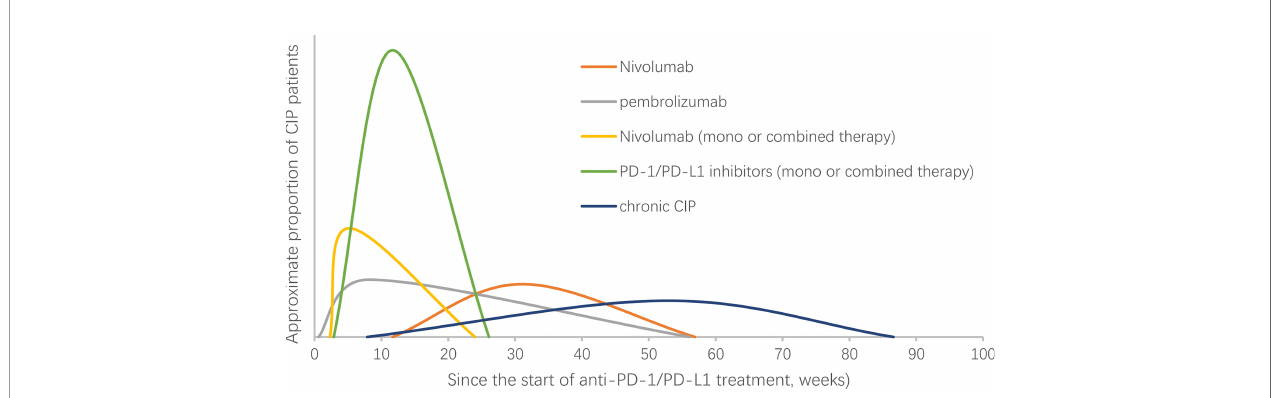
FIGURE 1 | Onset time of checkpoint inhibitor pneumonitis (CIP) in NSCLC patients receiving PD-1/PD-L1 treatment. NSCLC, non-small-cell lung cancer. The curve in the fi gure does not represent the change in the incidence of CIP over time. The abscissa of the highest point of the curve represents the median time of CIP reported in the studies (16, 18, 34, 35,